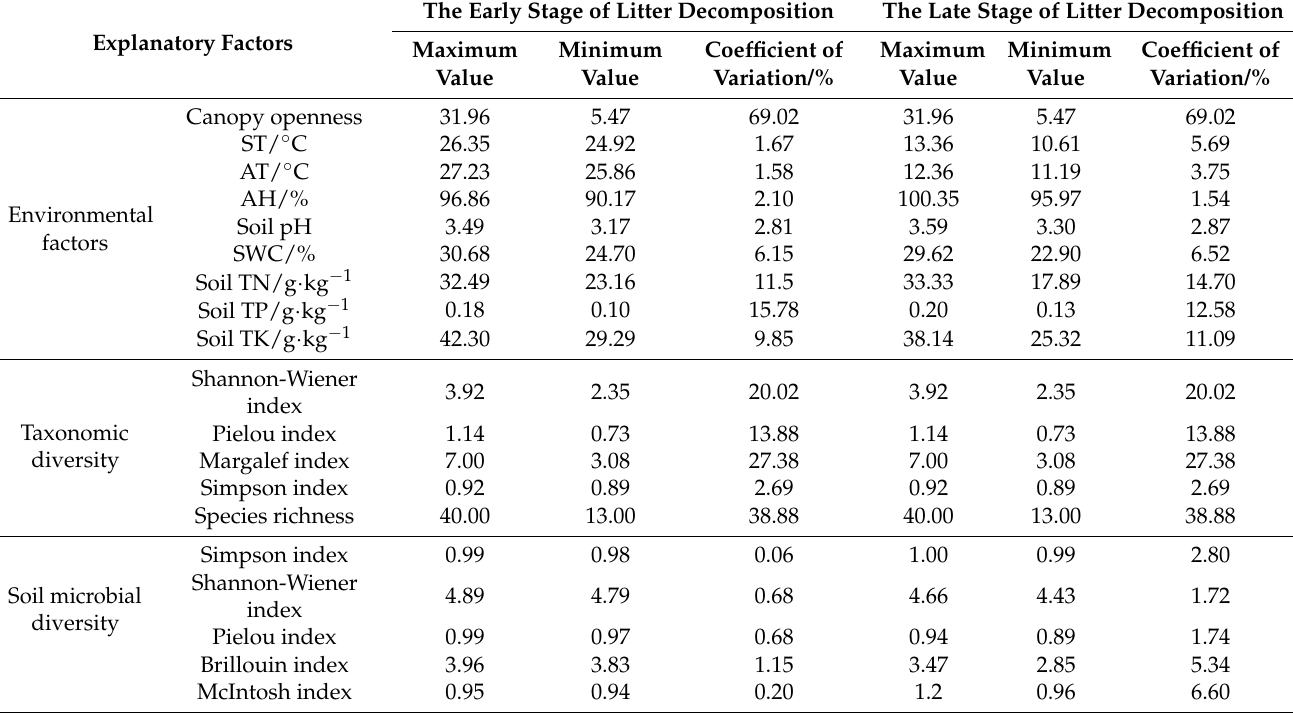
Table A2. Explanatory factors for litter decomposition in canopy gaps and